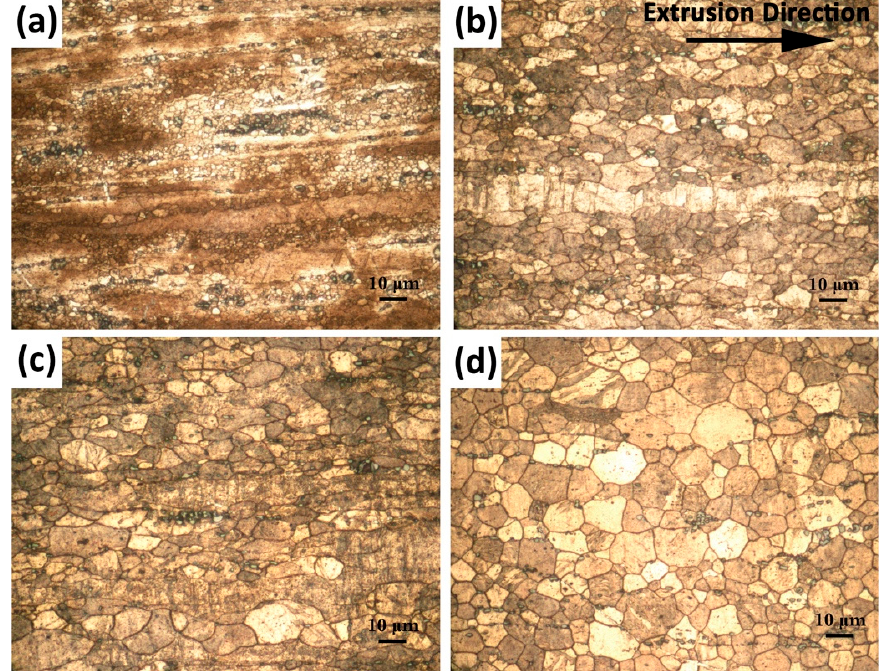
Figure 5. Optical micrographs of the alloys extruded at ( a ) 250 °C, ( b ) 300 °C, ( c ) 350 °C, and ( d ) 400 °C.